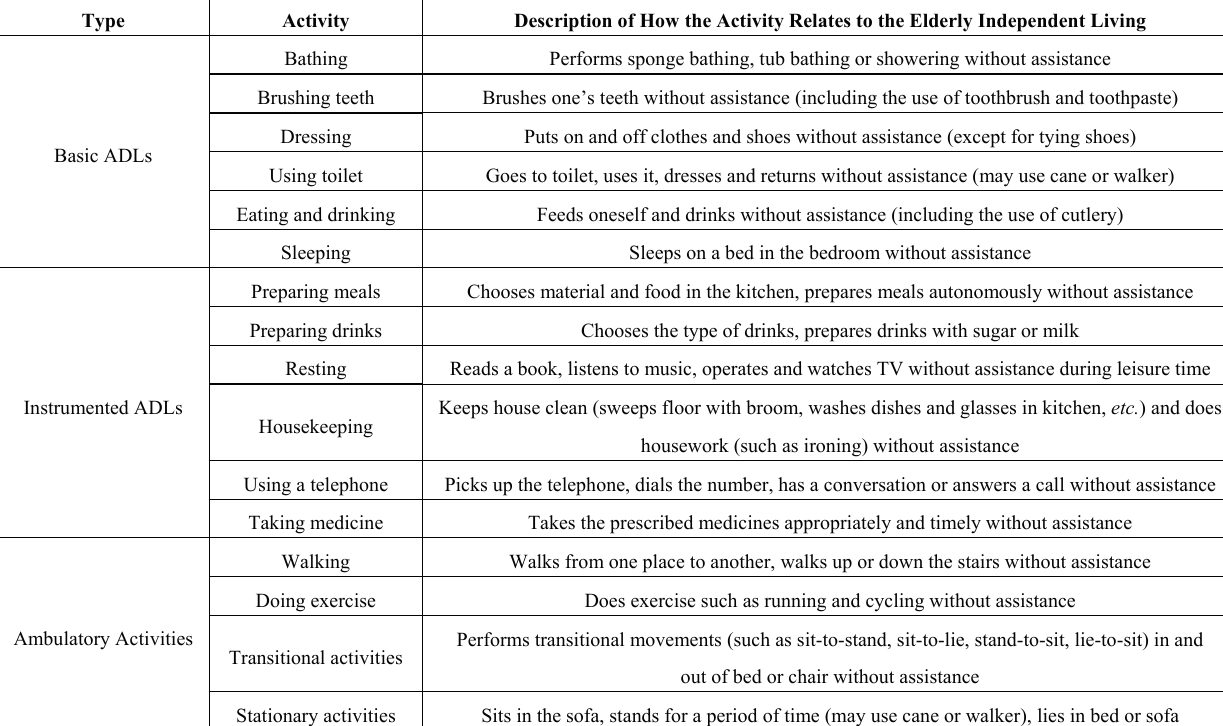
Table 1. Taxonomy of activities significant for the older adults in